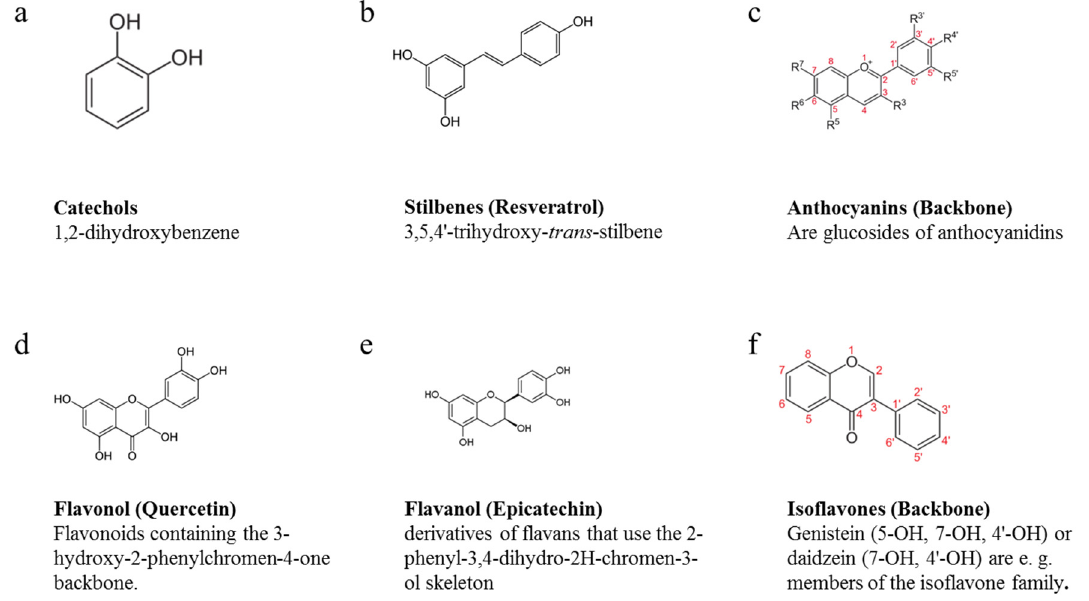
Figure 1. Chemical diversity polyphenols. Simple phenols are represented by ( a ) catechols and ( b ) stilbenes, and polyphenols in ( c ) anthocyanins, ( d ) flavonols, ( e ) flavanols and ( f )